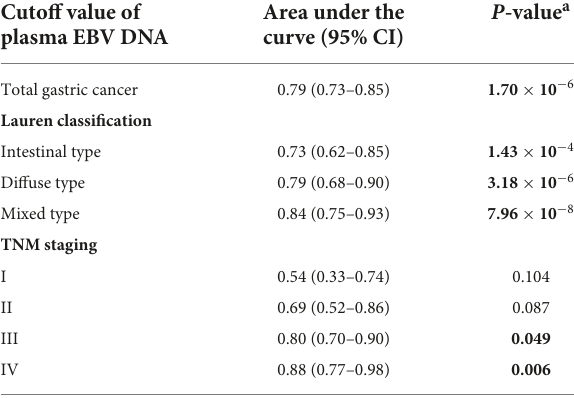
TABLE 6 Diagnostic performance of circulating cell-free Epstein–Barr virus (EBV) DNA for EBV-associated gastric cancer. Cutoff value of plasma EBV DNA